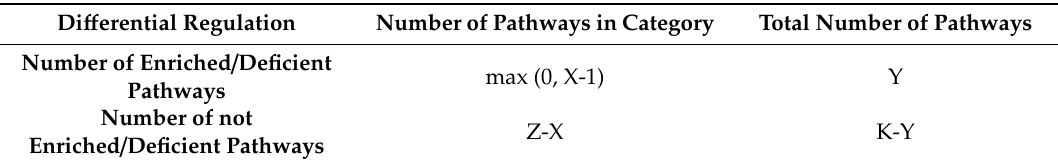
Table 1. Contingency table for the EASE score. X is the number of enriched / deficient pathways in the category, Y is the number of all enriched / deficient pathways, Z is the number of all pathways in the category, and K is the number of all pathways